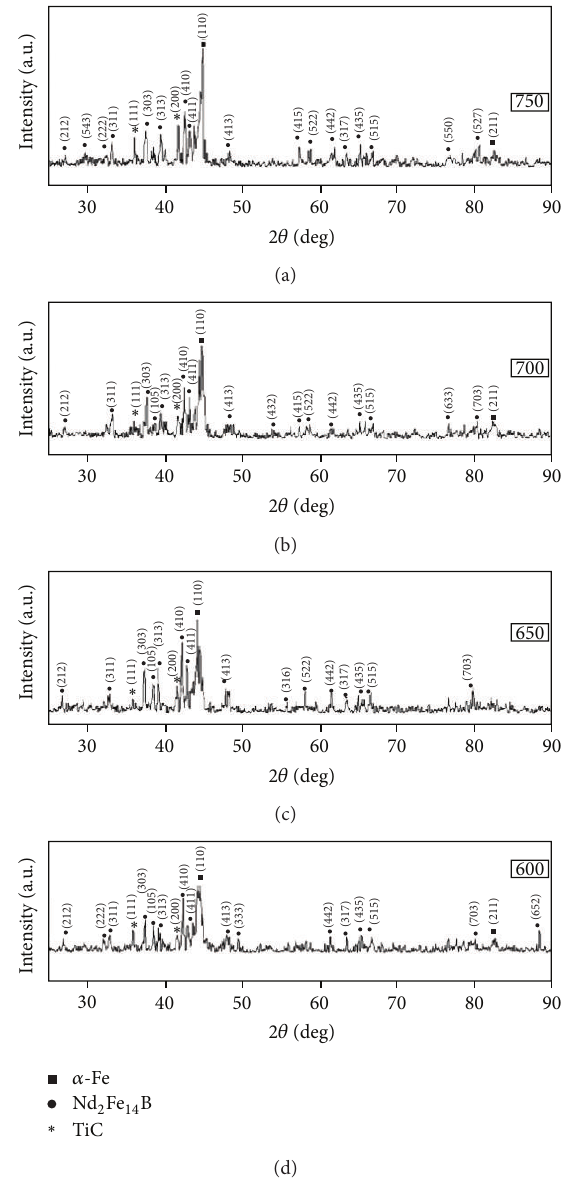
Figure 3: XRD patterns of Nd 9.4 Pr 0.6 Fe 74.5 Co 6 B 6 Ga 0.5 Ti 1.5 C 1.5 rib- bon after thermal treatment at different temperature for 10